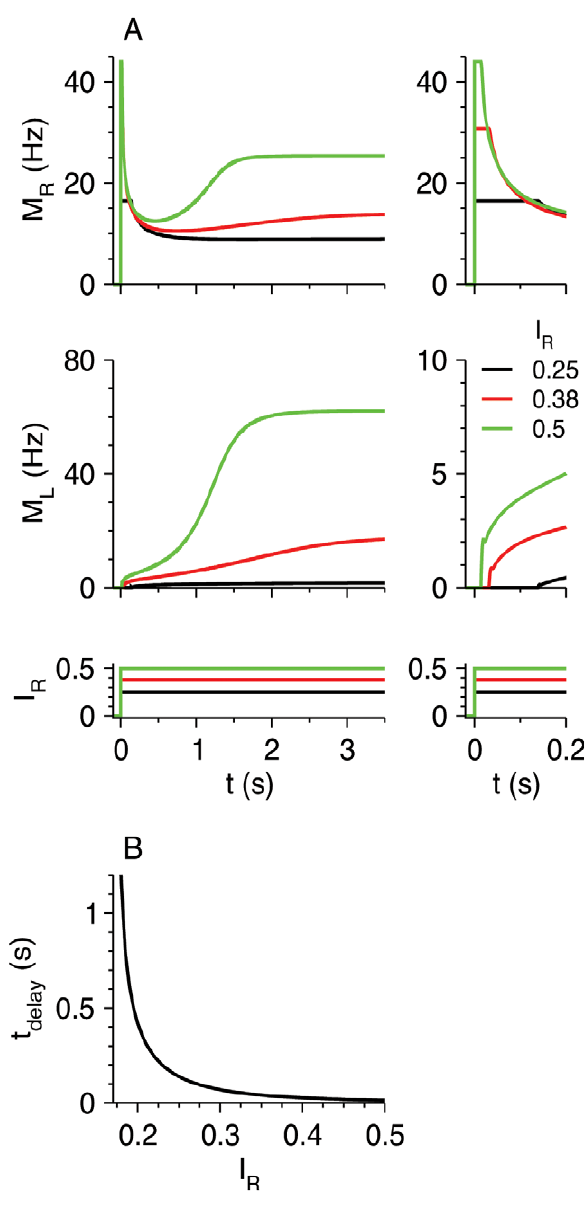
Figure 3. Response of the RS-LTS network with g RR =0 to step inputs I R H ( t ) to the RS neurons. Additional parameters are g RL =35, g LR =7.5. (A) Time courses of M R (top panels) and M L (middle panels) for I R =0.25 (black), 0.38 (red) and 0.5 (green)(bottom panels). The right top and middle panels depict the time course of M R and M L in a